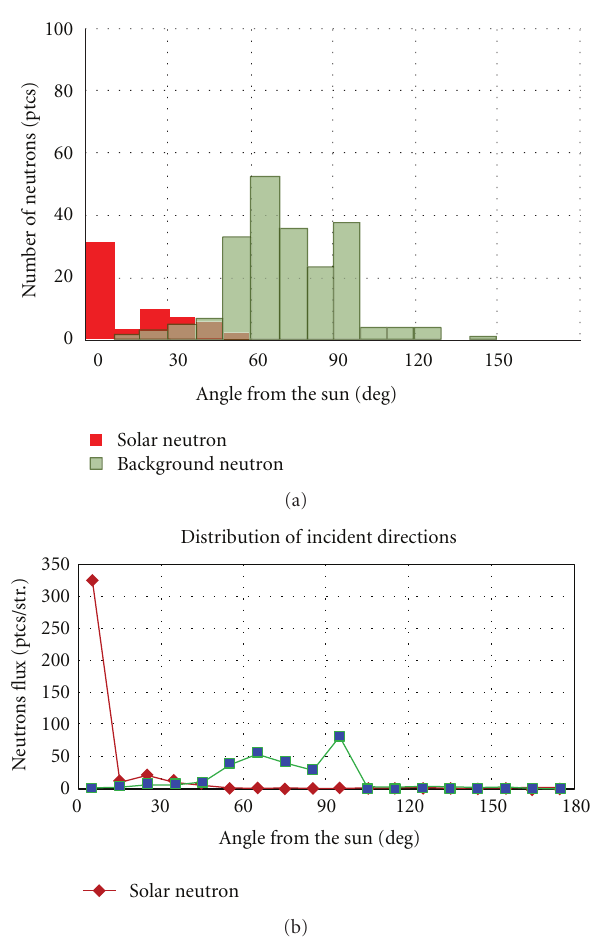
Figure 9: (a) The arrival directions of neutrons, as observed by the FIB sensor during the period 19:59 :43–20 :16 :34UT. Neutrons coming from the Sun (red) are shown separately from the background neutrons (dark green), but those neutrons are actually observed together by the FIB sensor. The number of events recorded during the above period was 364, and for 44, it was di ffi cult to determine the arrival direction due to low energy. A clear peak of neutrons can be identified within the region 0–20 degrees from the solar direction. Meanwhile, the candidates between 20 and 40 degrees may be neutrons from the Sun, induced by n-C scattering and also distributed at a relatively wide angle due to the limited angular resolution of the FIB sensor for the lowest energy neutrons (about 35 MeV). The bump of the background within the region 40–100 degrees from the solar direction corresponds to the background neutrons produced in the material of JEM by galactic cosmic rays. (b) The same data as used in the plot of (a). However the data were normalized by the solid angle. A sharp peak can be recognized for neutrons from the solar direction (red), while the background neutrons distribute in di ff erent angles presented by the green curve. The vertical value represents dN/d Ω . Total number of events during 20 :02–20 :16 UT was 273 and 54 for the background and for the signal respectively.